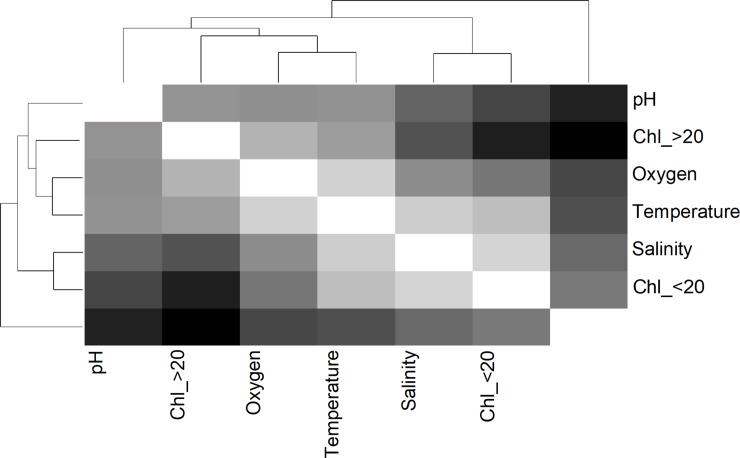
Map of significant correlations among oceanographic factors.Supported by Spearman rank correlations, the distance map suggests how the abiotic ambient changes from one temporal node to the other.